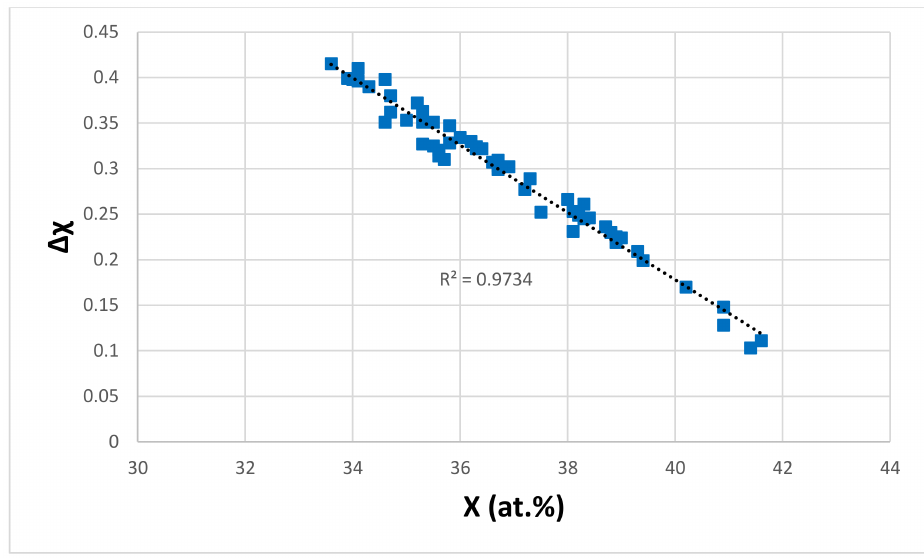
Figure 7. ∆ χ of tetragonal Nb 5 Si 3 versus X (= Al + B + Ge + Si + Sn) in Nb 5 Si 3 in Nb-silicide based alloys, see text.